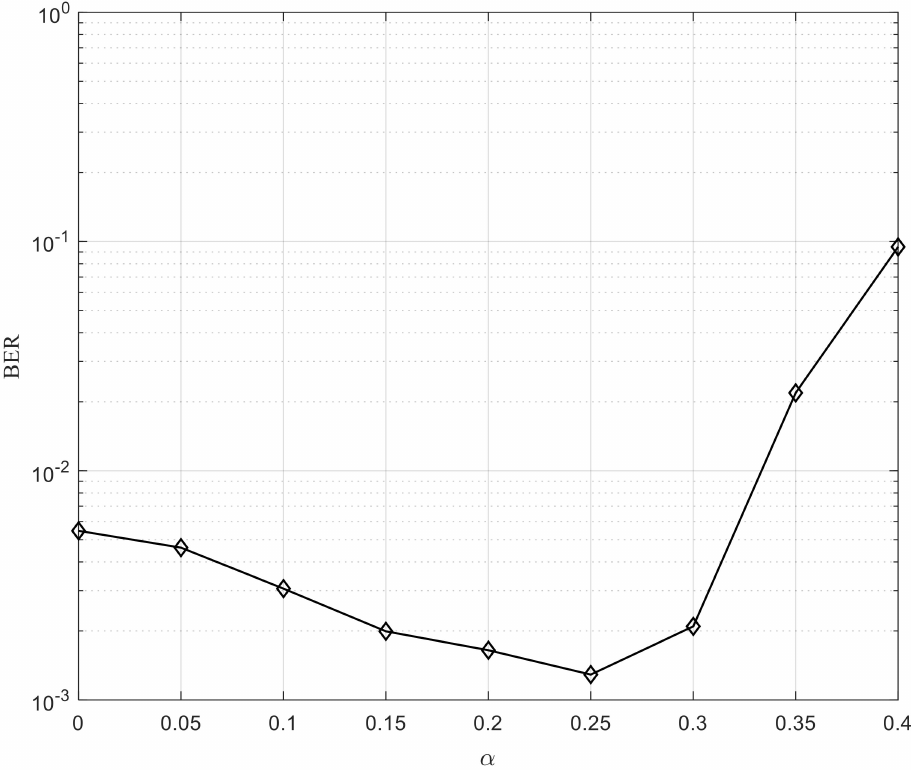
Figure 13. Bit error rate (BER) versus ε VA for modified VA.